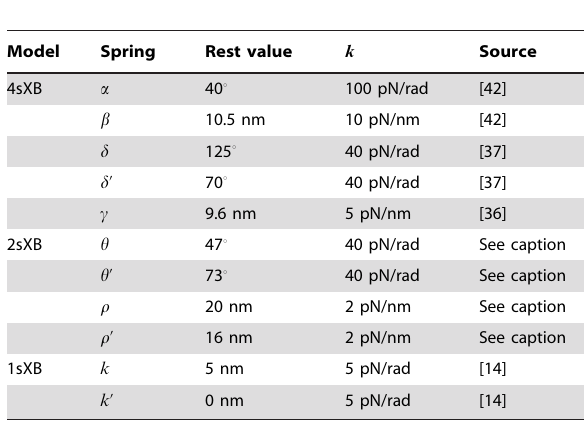
Table 1. Model parameters and their